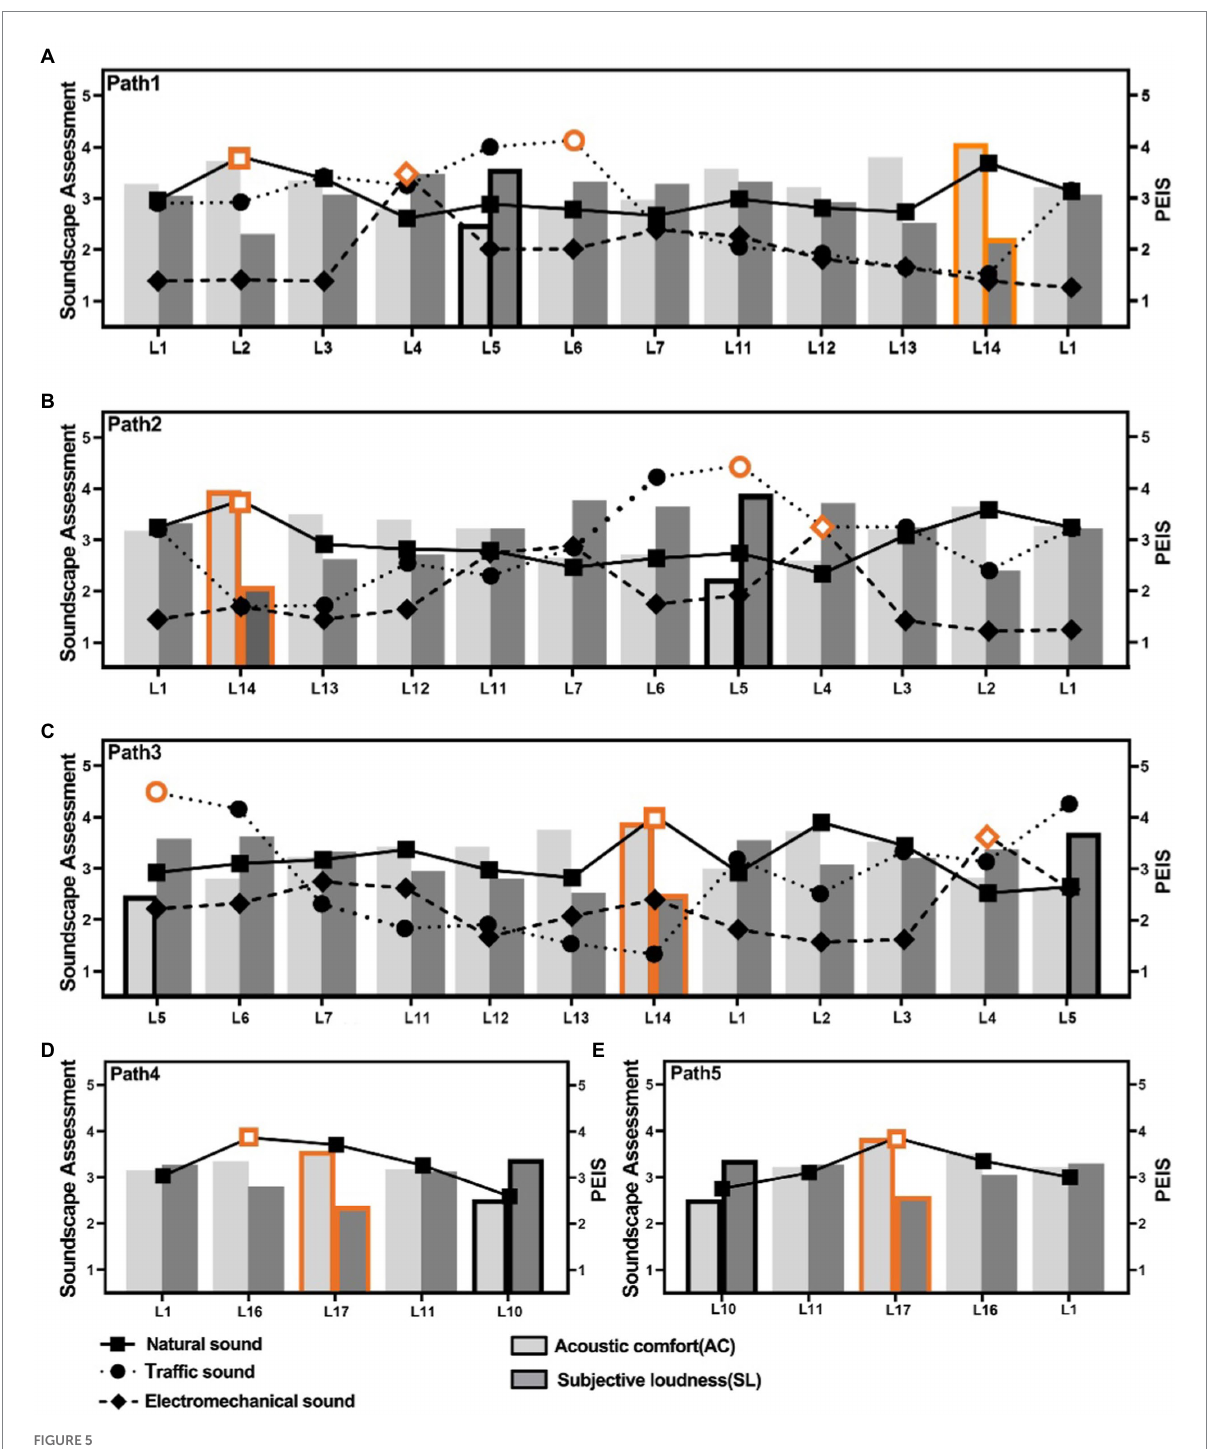
FIGURE 5 Soundscape assessment and PEIS at each location in the soundwalk paths: (A) soundscape assessment and the PEIS at each location in Path 1, (B) soundscape assessment and PEIS at each location in Path 2, (C) soundscape assessment and the PEIS at each location in Path 3, (D) soundscape assessment and the PEIS at each location in Path 4, and (E) soundscape assessment and the PEIS at each location in Path